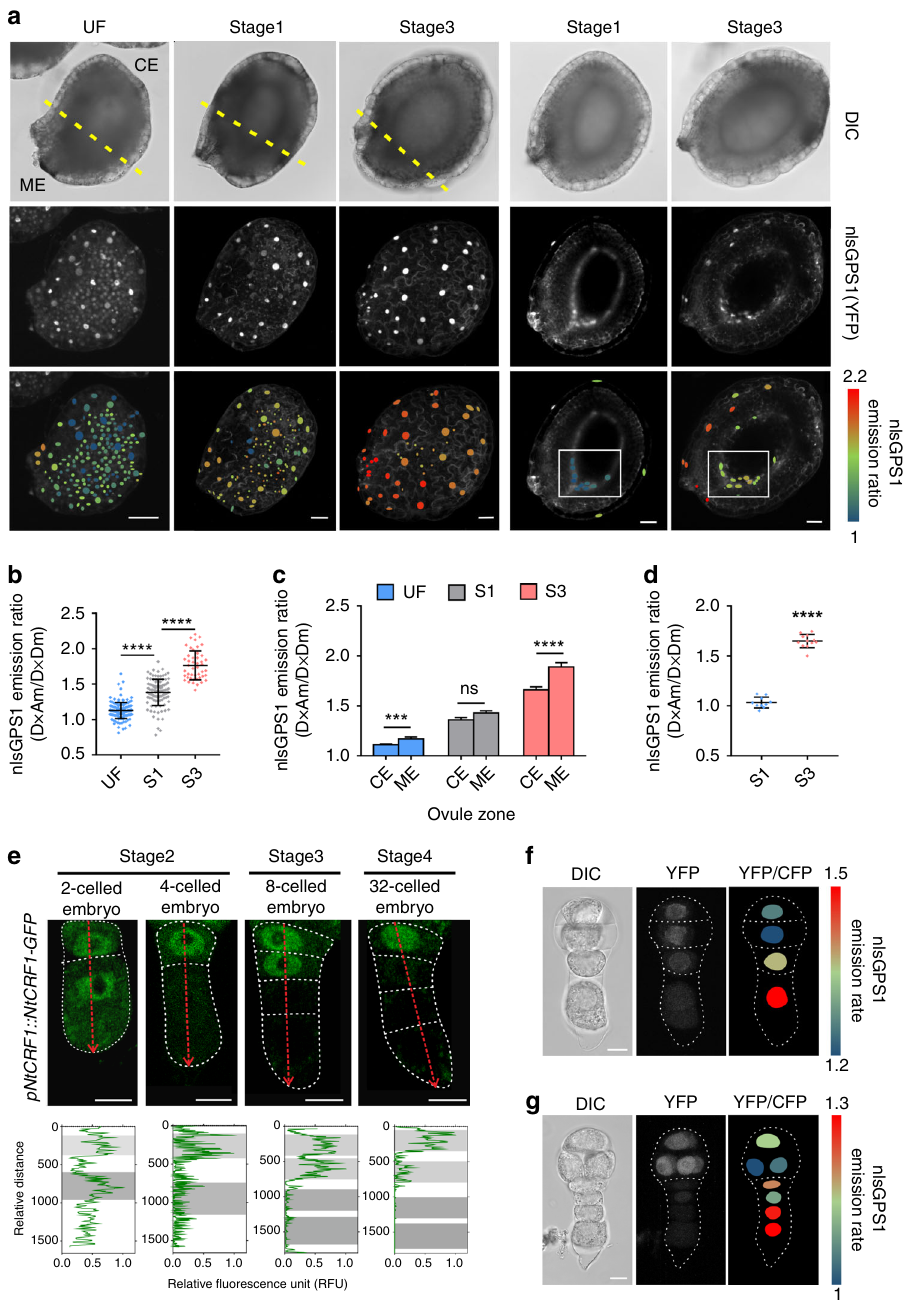
Fig. 5 Transient increase in, and polar distribution of, bioactive GA in seeds. a Left: Images of the nlsGPS1 emission ratios of unfertilized (UF), 4-DAP and 6- DAP seeds. Right: Images of the nlsGPS1 emission ratios of an optical section of a 4-DAP or 6-DAP seed. Boxes: micropylar endothecium. b Box plot of the nlsGPS1 emission ratios of the whole seed coat ( n > 46 nuclei). c nlsGPS1 emission ratios of the micropylar and chalaza ends [dashed lines in a ; n > 20 nuclei]. d Box plot of the nlsGPS1 emission ratios of stage 1 or 3 seeds [boxed region in a ; n > 10 nuclei]. e NtCRF1-GFP was absent from the basal SC at stage 3. Fluorescence signal intensities along a line across all SCs (red arrows). X -axis, relative GFP signal intensity (green); y -axis, relative distances along the line. Gray shading, positions of nuclei. f and g Images of the nlsGPS1 emission ratios of 4-celled and 12-celled proembryos in WT background. Data are the means± SD (standard deviations) (Student ’ s t -test; ns, P > 0.05; *** P < 0.001; **** P < 0.0001). ME micropylar end, CE chalaza end. Scale bars: 100 μ m ( a ), 10 μ m ( e – g ). The source data of the graphs are provided in the Source Data fi